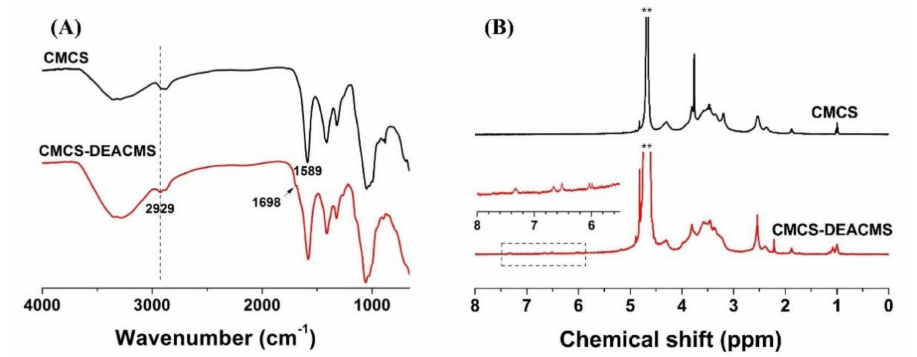
Figure 1. Characterization of CMCS-DEACMS conjugate. ( A ) FTIR spectra of CMCS and CMCS-DEACMS; ( B ) 1 H NMR spectra of CMCS and CMCS-DEACMS in D 2 O, inset is an enlargement of the CMCS-DEACMS spectrum from δ 6.00 to 8.00 to show DEACMS peaks. Asterisks (**) indicate